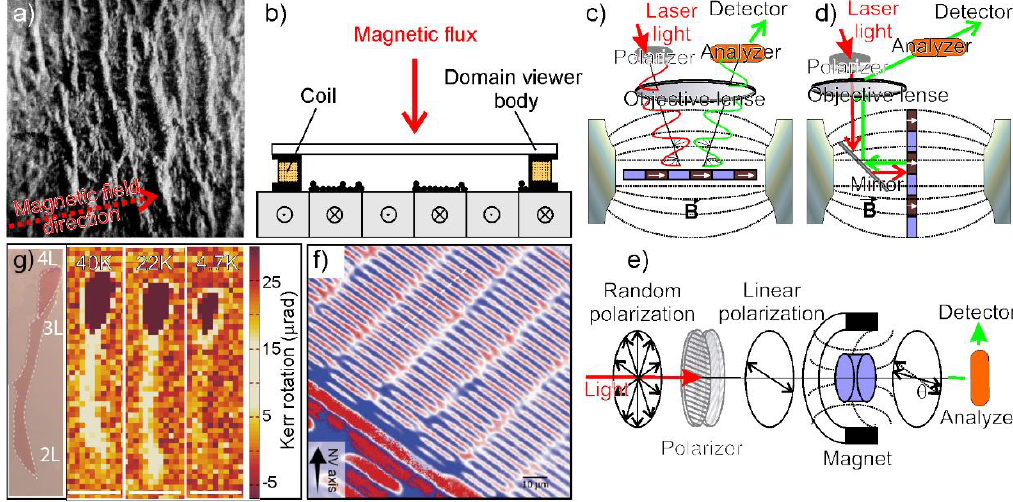
Figure 9. ( a ) Patterns obtained from Fe 2 O 3 nanoparticles on an iron-silicon alloy (Bitter technique) in large fields (16× magnification). The observed striations were found perpendicular to the applied magnetic field without any relationship to the grain structure for large magnetizations. Reproduced with permission from [132], published by American Physical Society, 1931; ( b ) representation of the magnetic domain viewer (modified Bitter technique). The technique employs a coil to generate a magnetic field perpendicular to the surface of the sample. Magnetization directions are shown into (X) and out of (O) the plane, respectively; ( c – e ) representations of the longitudinal, polar magneto-optical Kerr and magneto-optical Faraday effect configurations, respectively; ( f ) magneto-optical imaging of a thin ferromagnetic film using a diamond-based sensor. Reprinted from [122] (published by Nature Publishing Group, 2016) licensed under CC BY 4.0; ( g ) optical (left panel) and Kerr images (right panels) of a few-layered Cr 2 Ge 2 Te 6 crystal exfoliated on SiO 2 / Si obtained at different T. The layer number (2L, 3L, or 4L) is indicated by arrows in ( g ). Scale bars in ( g ) are 10 μm. Image adapted from [133], published by Springer Nature, 2017.